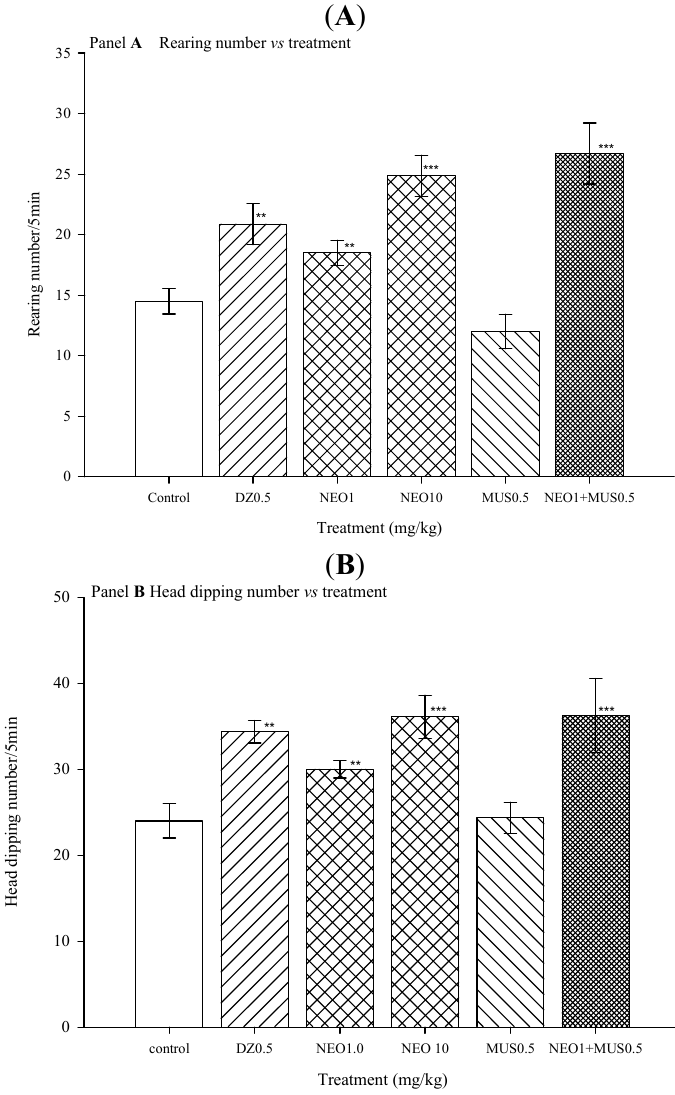
Figure 6. Effect of co-administration of muscimol (MUS) plus NEO in hole-board test. ( A ) Rearing number vs. treatment; ( B ) Head dipping number vs.